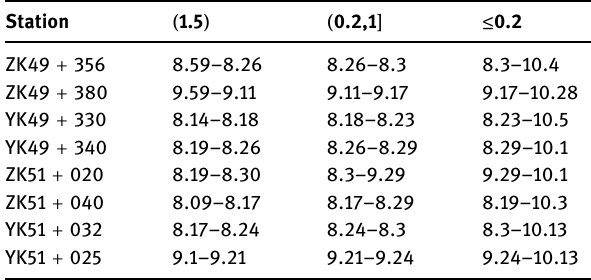
Table 3: Distribution range of displacement rate of partial section